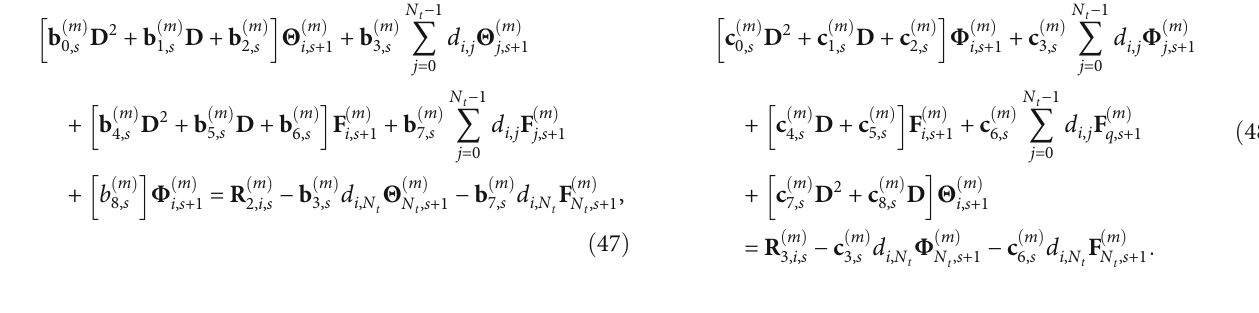
Figure 16: Concentration pro fi le for di ff erent values of Pr when De = 0 : 1, N = 0 : 5, n = 0 : 5, f = δ = NR = 0 : 2, Sc = 0 : 6 , and Pr = 1 :